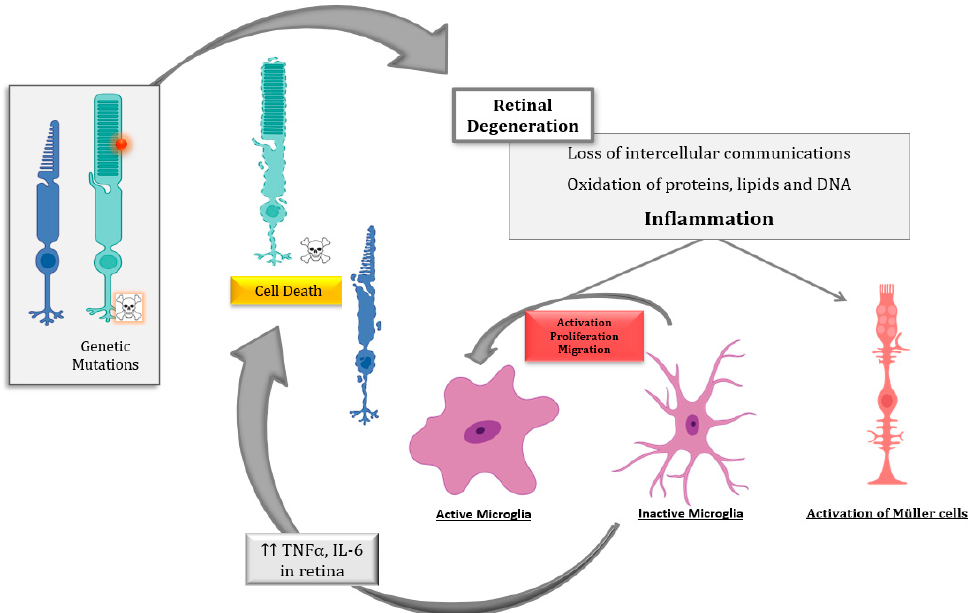
Figure 2. Schematic representation of the inflammatory processes underlying photoreceptor degeneration in retinitis pigmentosa, the most common inherited retinal dystrophy (IRD). The genetic defect leads to rod degeneration. During rod degeneration several cellular processes are activated, including inflammation and oxidative stress, which lead to the loss of intercellular communications, the oxidation of macromolecules, and the activation of microglia and Müller cells, among others. Activated microglia cells release inflammatory molecules such as cytokines (tumor necrosis factor alpha (TNF α ) and interleukin 6 (IL6)), chemokines, etc., which would exacerbate photoreceptor degeneration (both rods and cones) through different cell death mechanism such as necroptosis, parthanatos, apoptosis, etc.